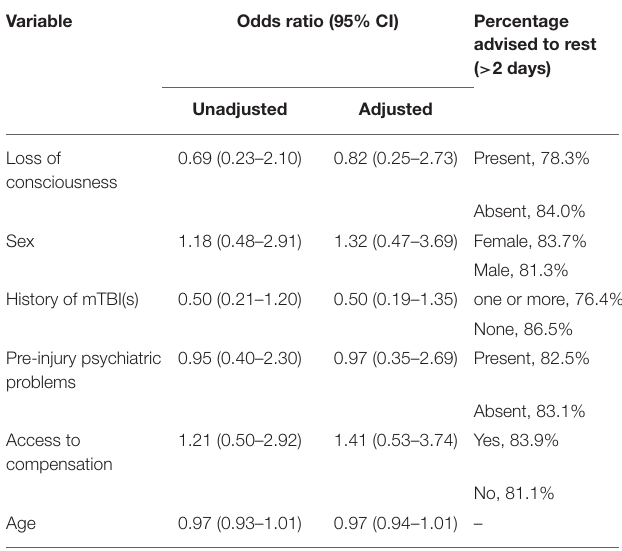
TABLE 2 | Logistic regression models.